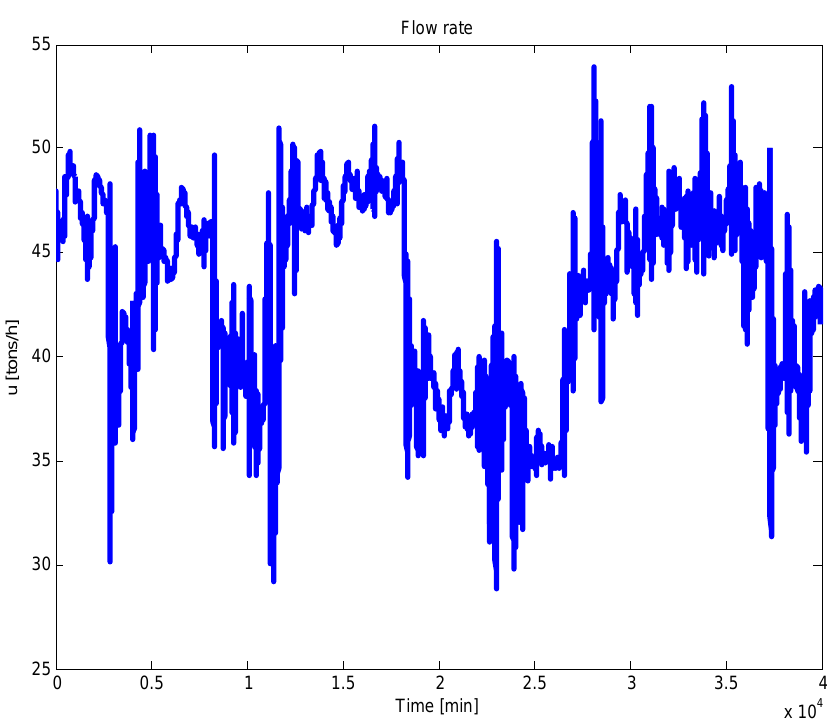
Figure 8. Flow rate experimental data of HX4 for a month